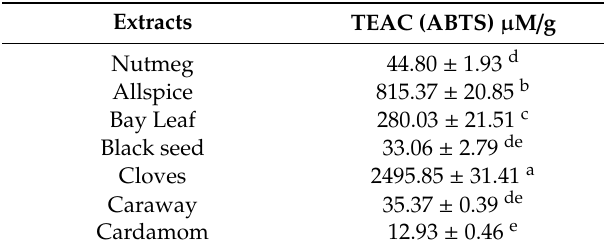
Table 1. ABTS • + radical scavenging activity of spice